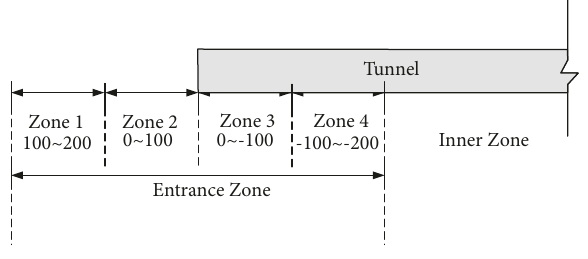
Figure 3: Division of zones at the tunnel